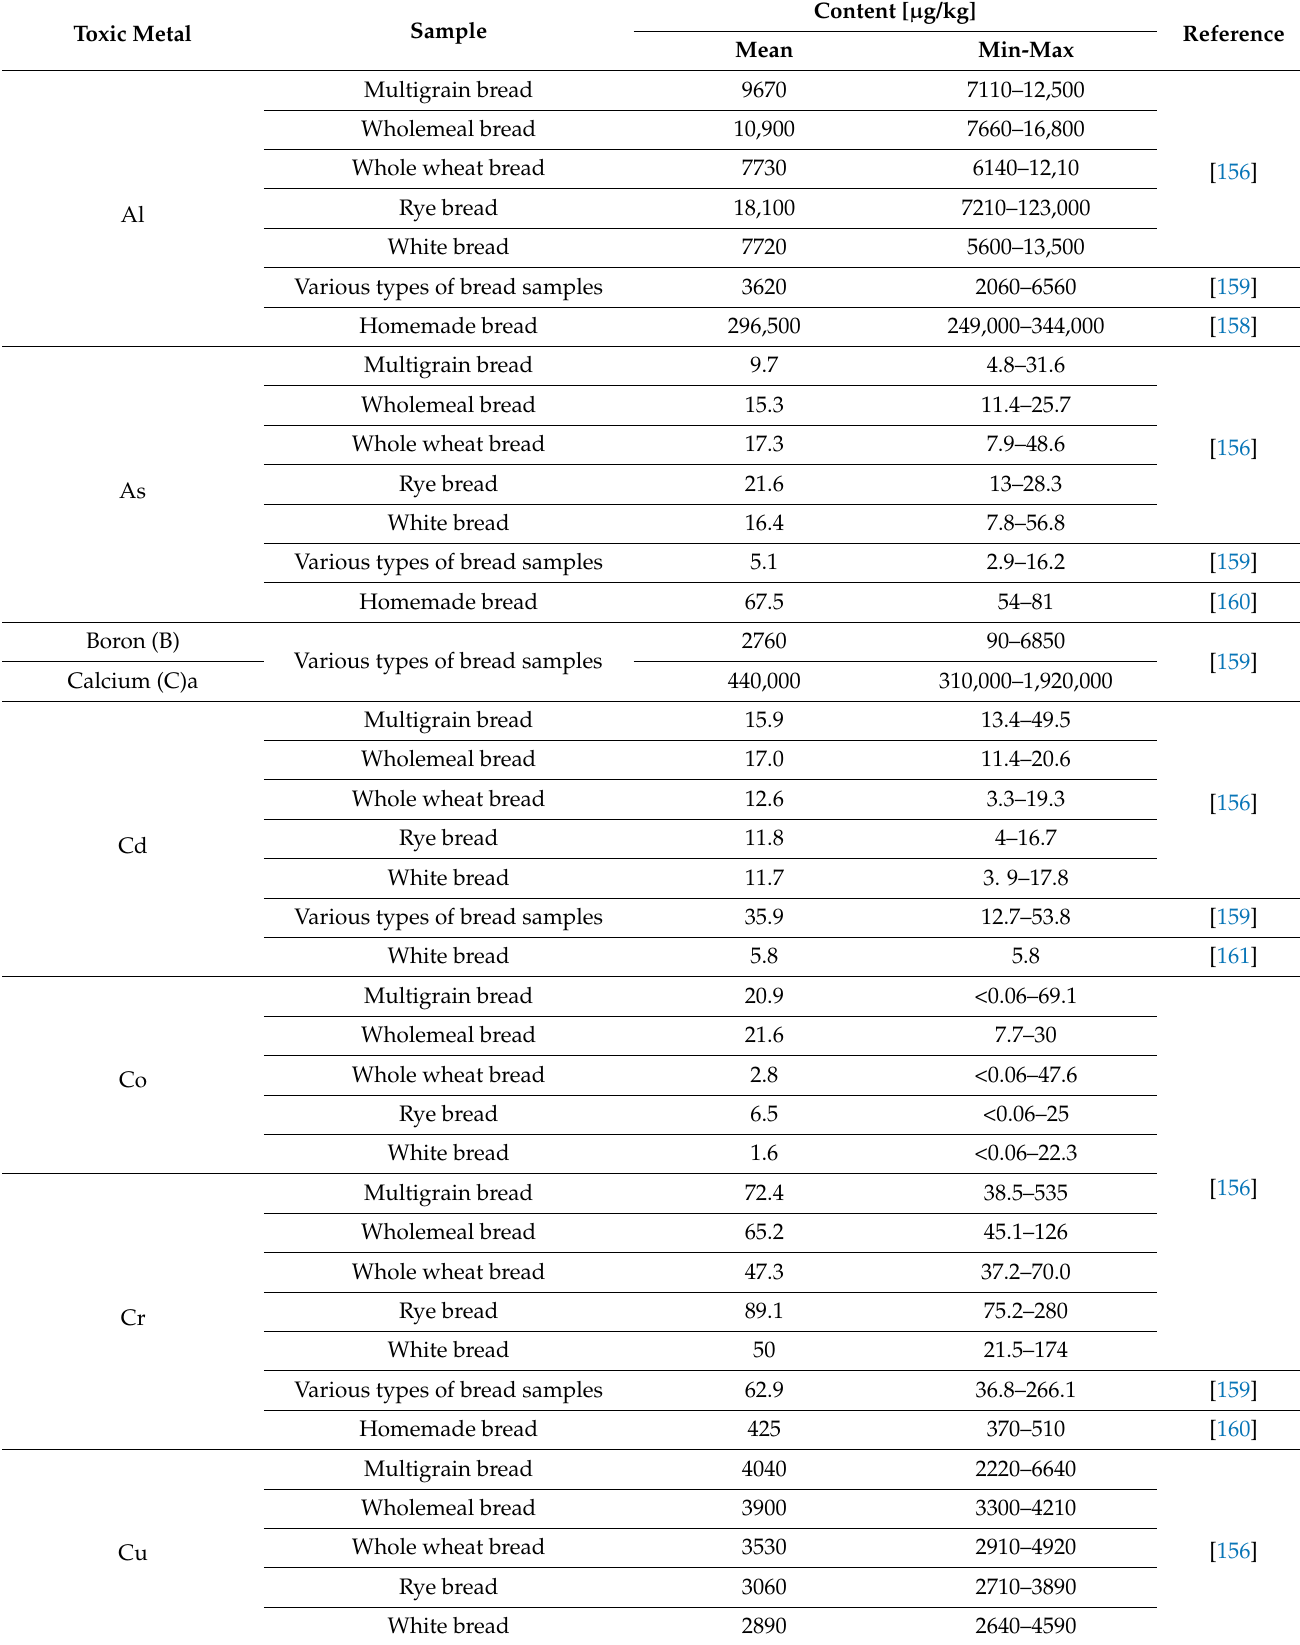
Table 5. Current toxic metal inputs among various types of bread